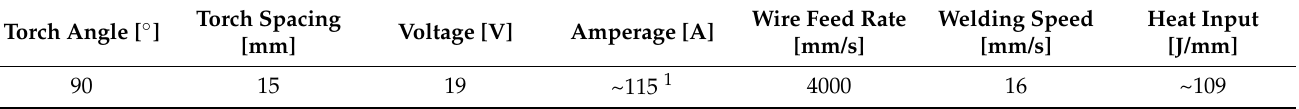
Figure 1. Schematic sketch of the deposition process. Table 2. Applied GMAW parameters for processing of tool steel X36